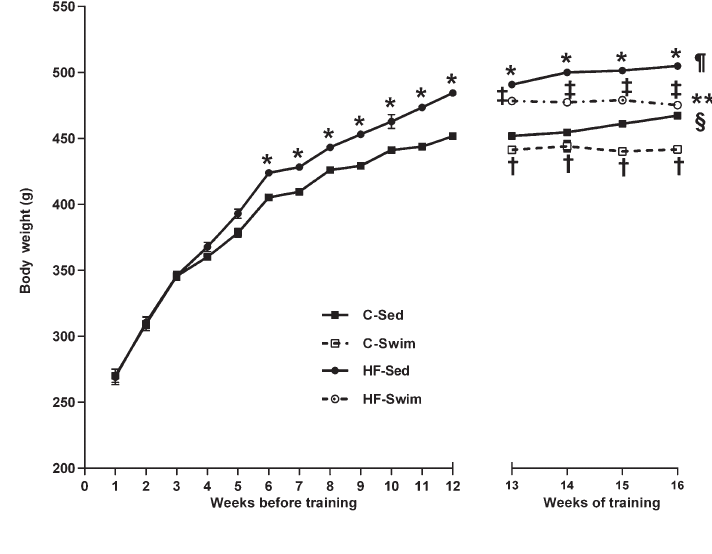
Figure 1. Body weight (g) of control and high-fat diet-fed rats. Data are reported as means±SE for n=6-7 rats/group. *P , 0.05, sedentary high- fat diet group (HF-Sed) vs sedentary control group (C-Sed); { P , 0.05, C-Sed vs exercised control group (C-Swim); { P , 0.05, HF-Sed vs exercised high-fat diet group (HF-Swim); 1 P , 0.05, C-Sed 12th week vs 16th week; " P , 0.05, HF-Sed 12th week vs 16th week; **P , 0.05, HF-swim 12th week (pre-exercise) vs 16th week (post-exercise) ( t